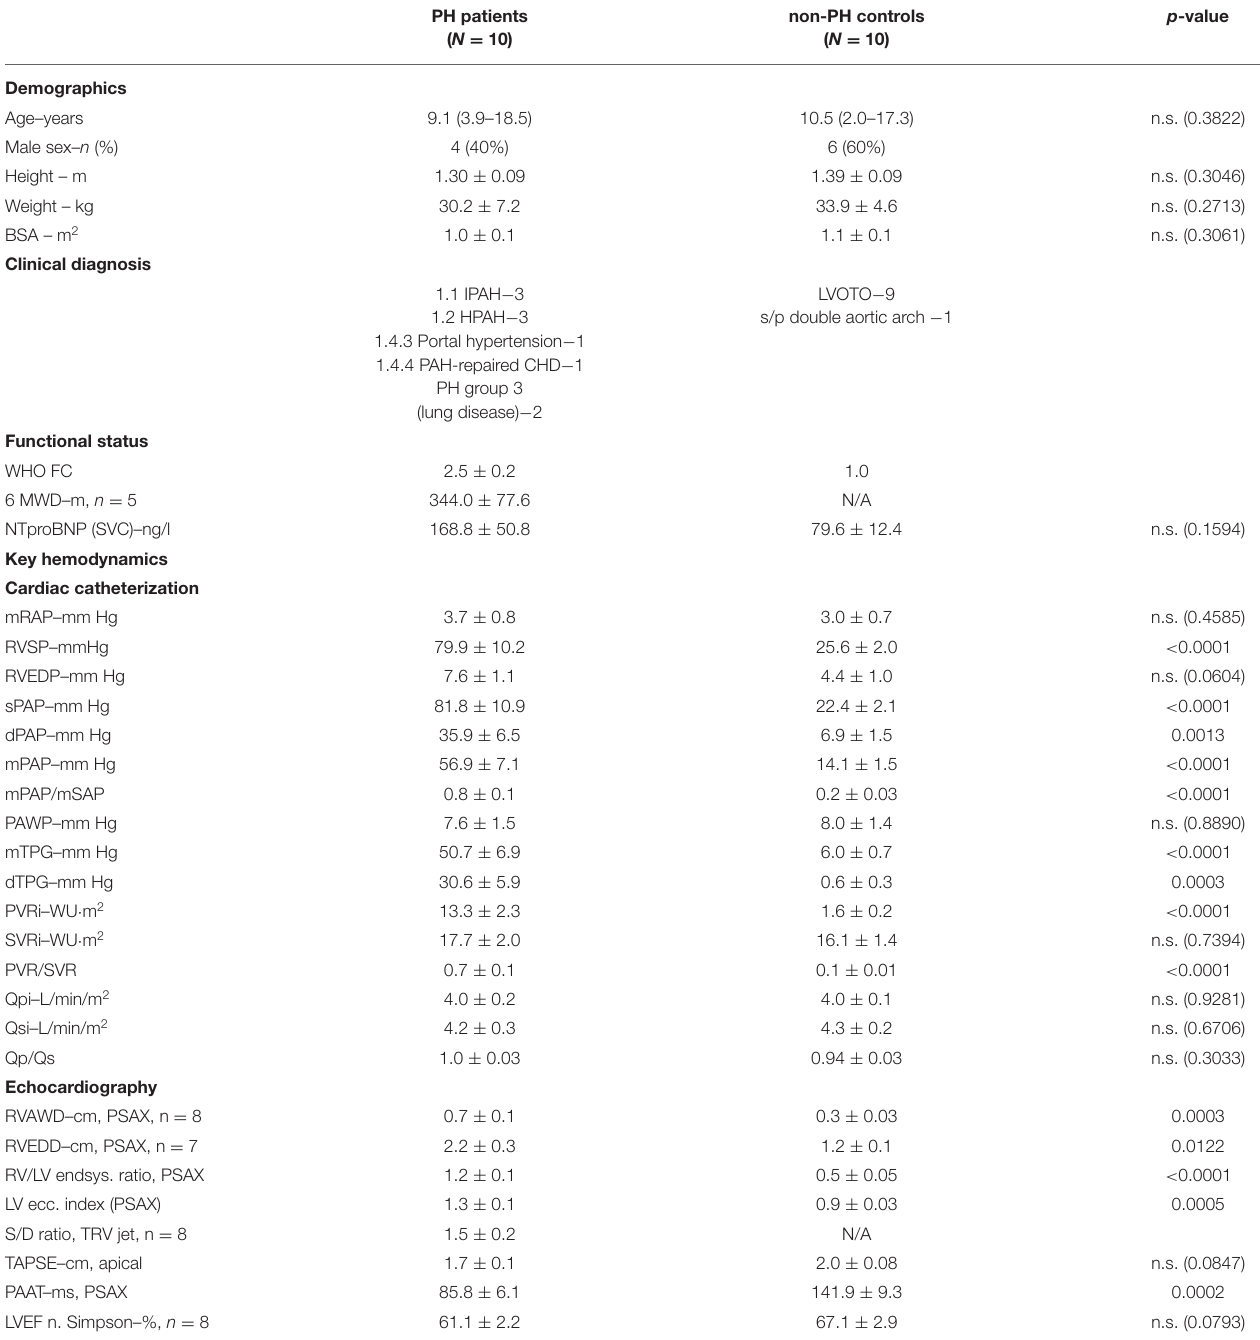
TABLE 1 | Characteristics of PH patients and non-PH